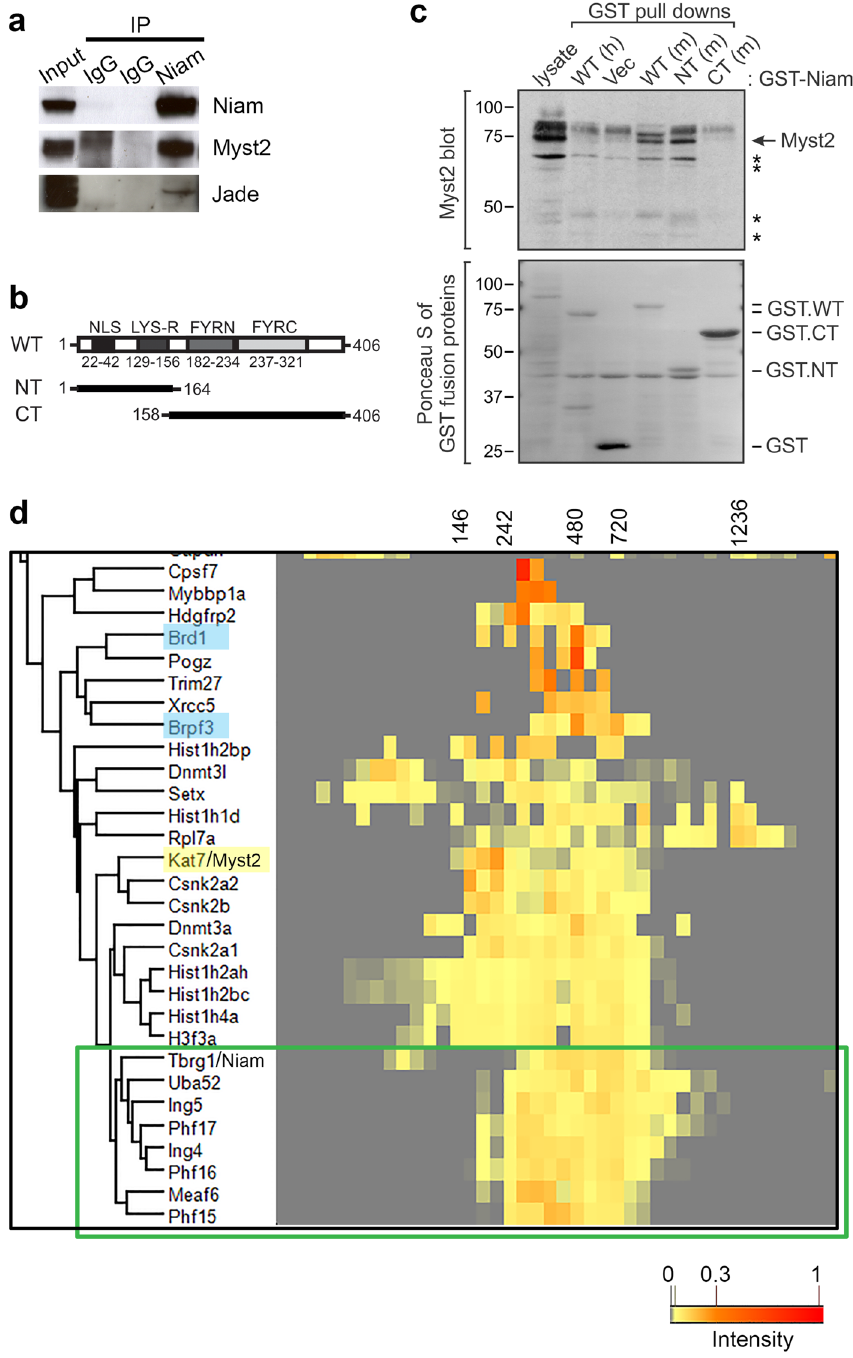
Figure 3. Niam is a novel Myst2-associated protein. ( a ) Validation of the interaction between Myst2 and Niam by reverse co-immunoprecipitation. Endogenous Niam was immunoprecipitated from lysates of wild type ESCs, and the immunoprecipitate was probed with antibodies for the presence of native Myst2. Full-length blots are presented in Supplementary Fig. S4. ( b ) Schematic of wild-type (WT) mouse Niam and deletion mutants NT (residues 1–164) and CT (residues 158–406). The predicted nuclear localization sequence (NLS), lysine-rich region (LYS-R) and ‘FY’ rich regions in the C-terminus are shown. ( c ) Endogenous Myst2 in mESC lysates interacts in vitro with GST-tagged WT and NT forms of mouse (m) Niam, but not the CT mutant or GST control. GST-tagged human (h) Niam failed to bind full-length Myst2 (arrow). Asterisks indicate Myst2 antibody-detected bands of lower MW that displayed more selective binding to WT (m and h) and NT Niam. GST protein levels were assessed by Ponceau S staining of the membrane. ( d ) Hierarchical clustering of Myst2-copurifying proteins according to the similarity of their blue native PAGE migration profile. The heatmap represents protein intensities across all the fractions. The green box encloses Myst2 H4 HAT (JADE) complex subunits. Subunits of Myst2 H3 HAT (BRPF) complex are highlighted in light blue. The annotated molecular weights (kDa) were estimated from the migration distances of standards run in